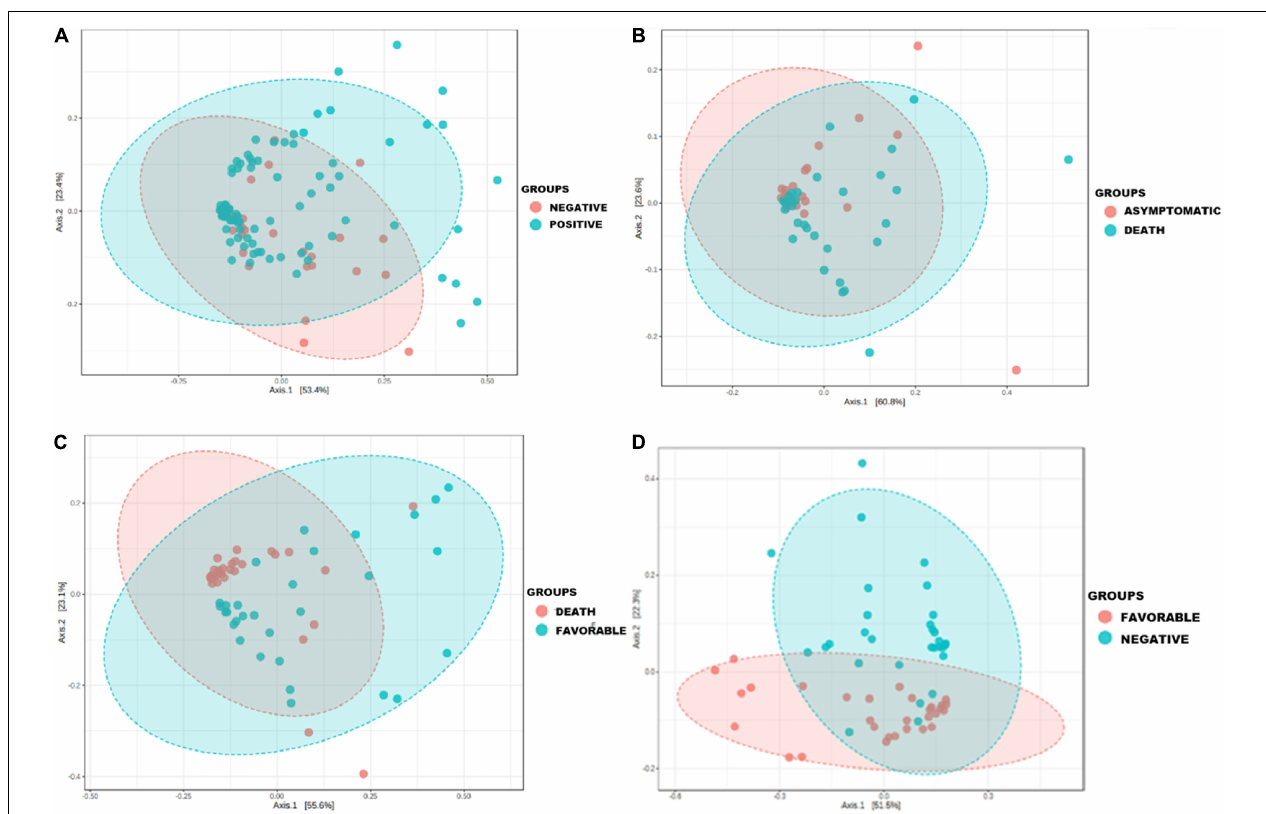
FIGURE 1 | Principal coordinate analysis showing the change in the nasopharyngeal microbiota profile during COVID-19 airway infection in clinical patient groups versus COVID-19 negative group. Principal component analysis (PCoA) was performed on species from raw data (number of reads) using the Jensen Shannon divergence distance matrix and the Multivariate Analysis of Variance (MANOVA) statistical test. Each sample is represented by a point: (A) the microbiota profile of COVID-19 negative patients and cases ( p ≤ 0.006); (B) the microbiota profile in asymptomatic patients and deceased patients ( p ≤ 0.001); (C) the microbiota profile in patients with a favorable outcome and deceased patients ( p ≤ 0.001); (D) the microbiota profile in patients with a favorable outcome and COVID-19 negative individuals ( p ≤